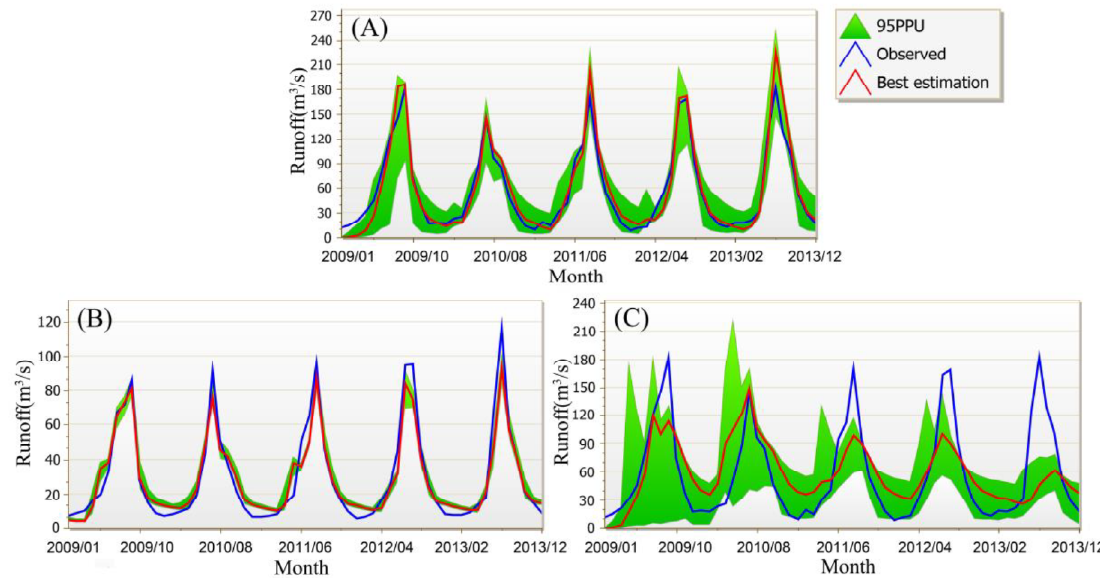
Figure 8. Simulation results of monthly average runoff by the three different modes at Ying Luoxia control station from 2009 to 2013: ( A ) CMADS + SWAT mode; ( B ) TWS + SWAT mode; ( C ) CFSR + SWAT mode.